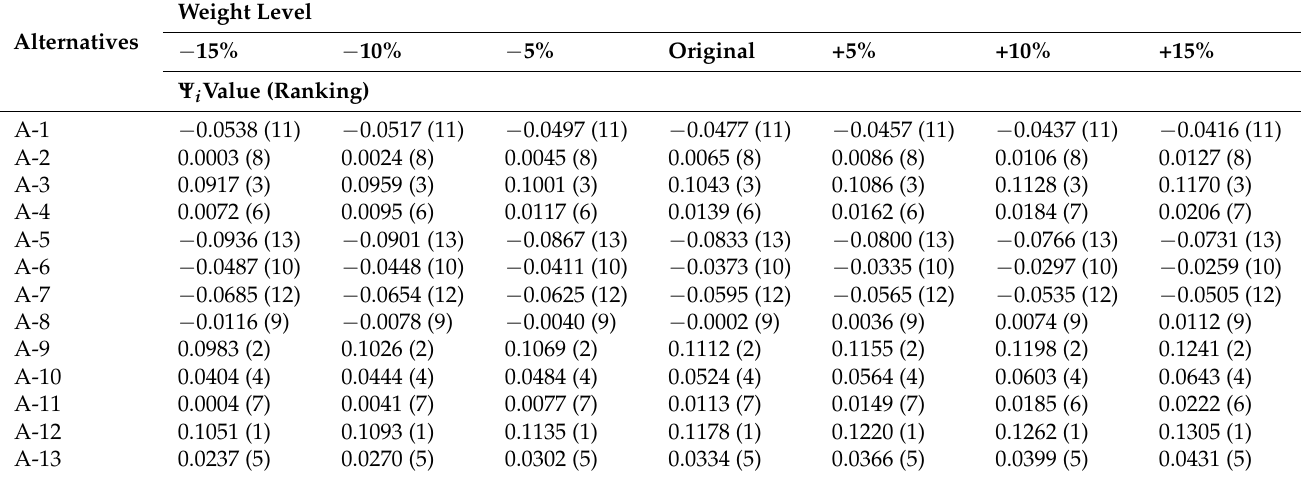
Table 7. Weight sensitivity of C-6 (fracture toughness) on ranking.